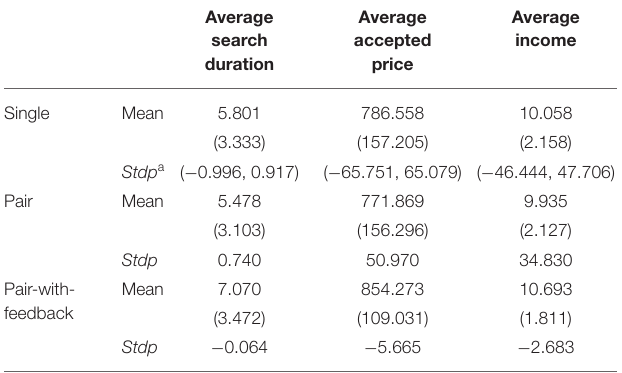
TABLE 2 | Mean and Stdp of search variables in each